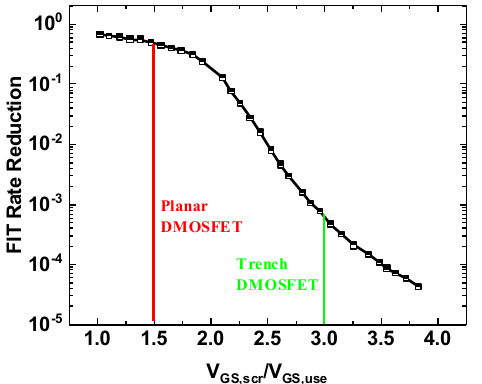
Figure 8. More efficient screening of extrinsic defects in Trench MOSFETs by means of gate voltage screening as compared to planar MOSFETs [16]. The above figure is reproduced from reference [16]. The dots do not represent experimental data.